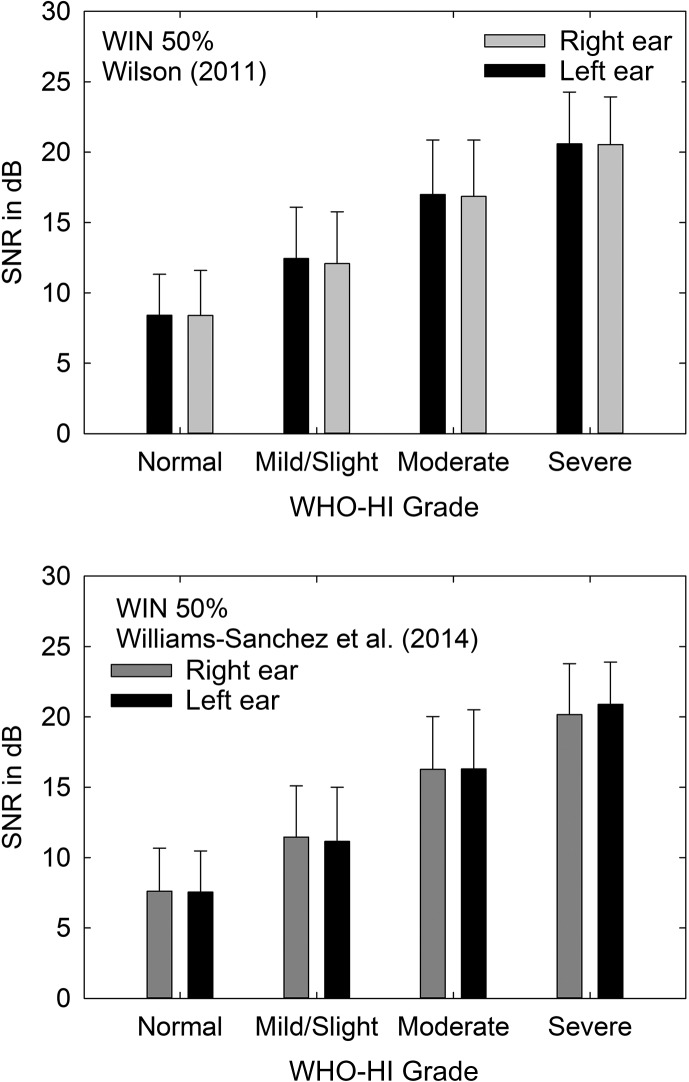
Mean (+1 SD) speech-to-noise ratios (SNR) in dB plotted as a function of World Health Organization (WHO) hearing impairment (HI) grade for clinical data sets from Wilson (2011, top) and Williams-Sanchez et al. (2014, bottom). Data are shown separately for the right and left ears, and ear-specific WHO-HI grades are indicated on the x-axis. WIN = words-in-noise.